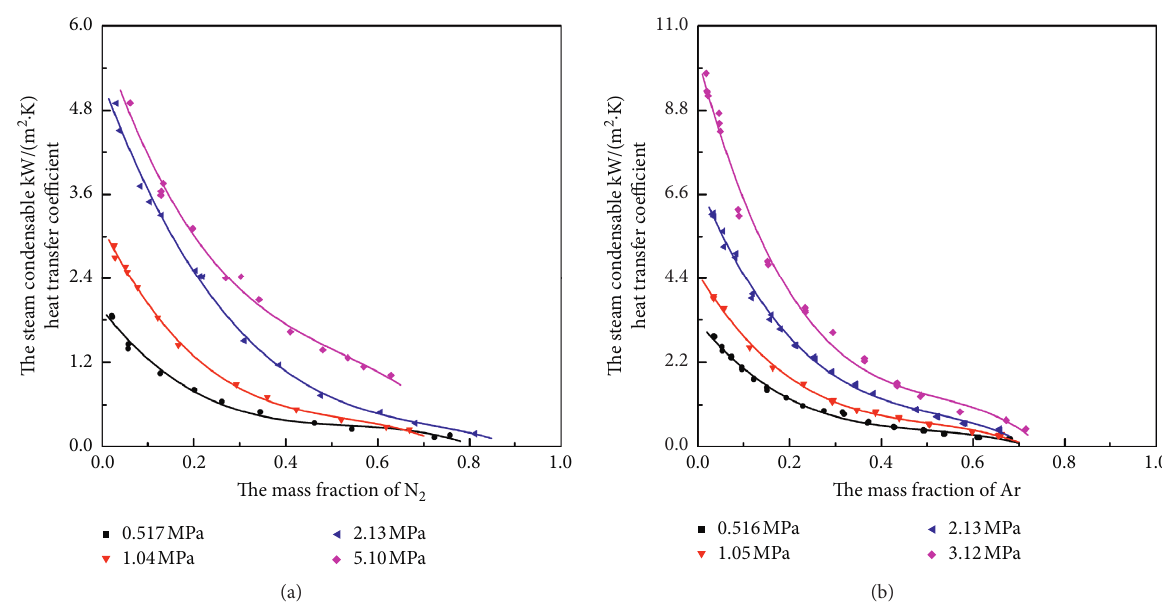
Figure 9: Effects of the molar fraction of noncondensable gas. (a) N